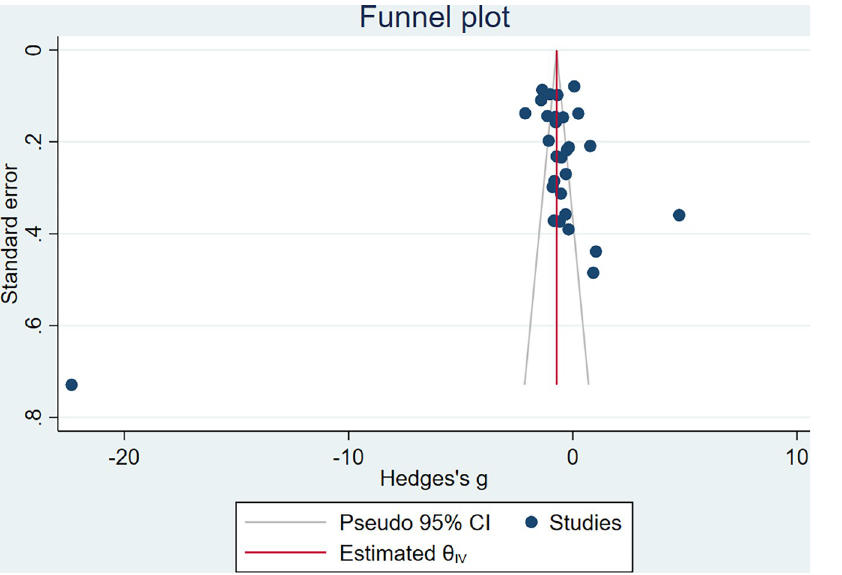
Fig 17. Funnel plot for meta-analysis of BDNF levels in patients with DM.